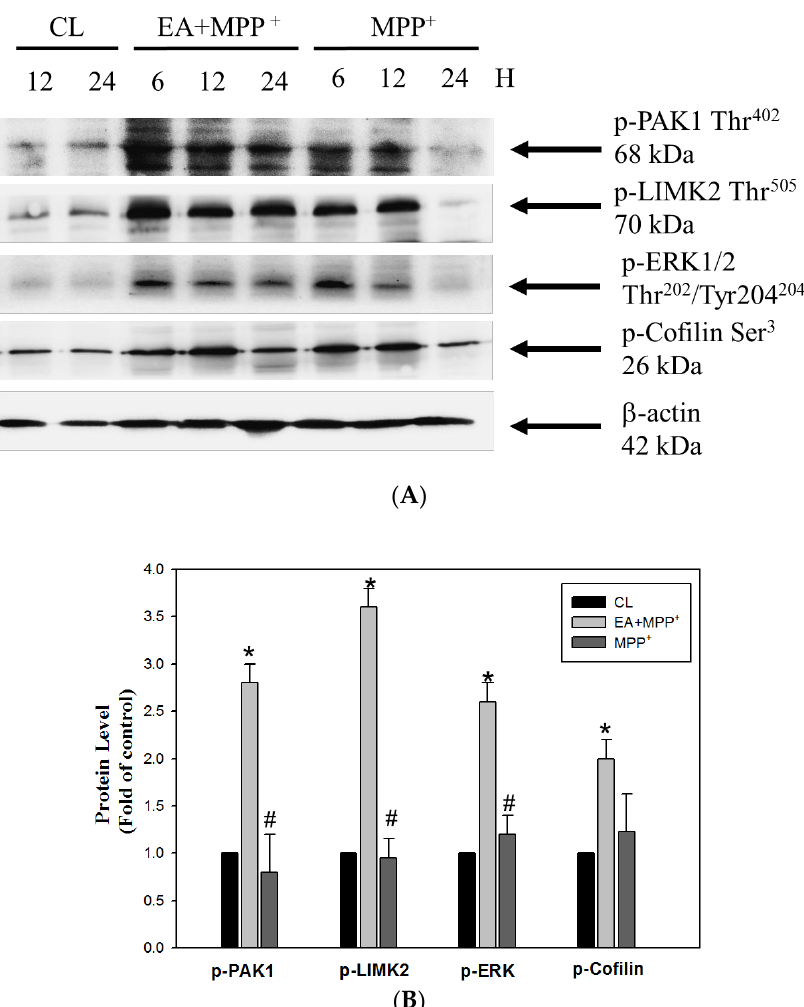
Figure 4. (A) Erinacine A enhanced phosphorylation of PAK1/LIMK2/MEK/Cofilin under MMP + challenge. Western blotting for phosphorylation of PAK1, LIMK2, MEK, and Cofilin, as well as β-actin (loading control) in the N2a cells treated with 0.1% DMSO, MPP + , or MPP + and erinacine A for 24 h. (B) The quantitative procedure of the immunoblots at 24 h was described previously. Data are expressed as the fold increase of the control group (mean ± SEM); * p < 0.01, as compared to the control group; # p < 0.01, as compared to the MPP + -treated group.